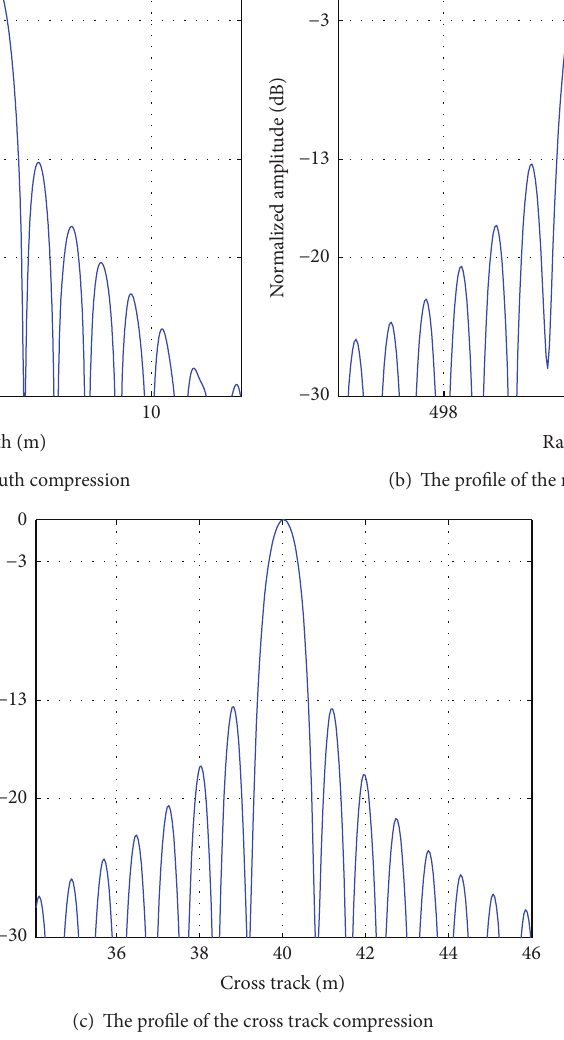
Figure 8: The profiles of the extracted point